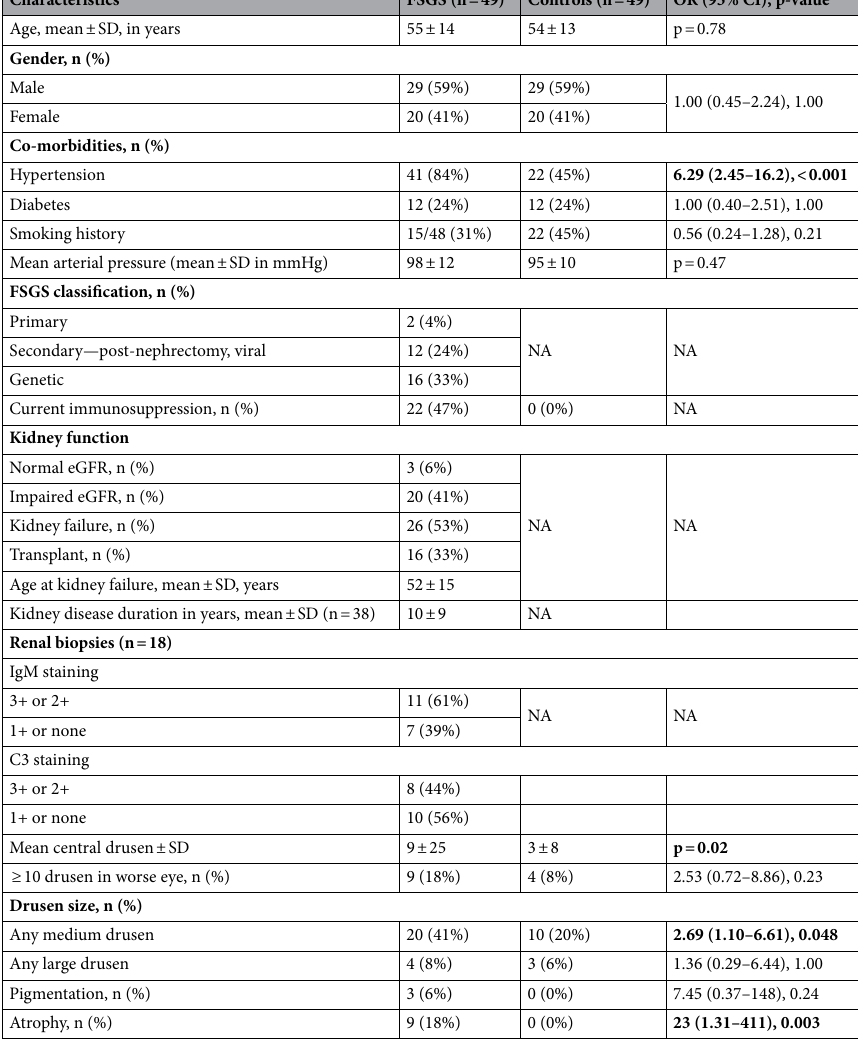
Table 4. Clinical features and drusen in Focal and Segmental Glomerulosclerosis and controls. Significant values are in bold. CI confidence interval, eGFR estimated glomerular filtration rate mL/min/1.73 m 2 , IQR interquartile range, SD standard deviation, NA not